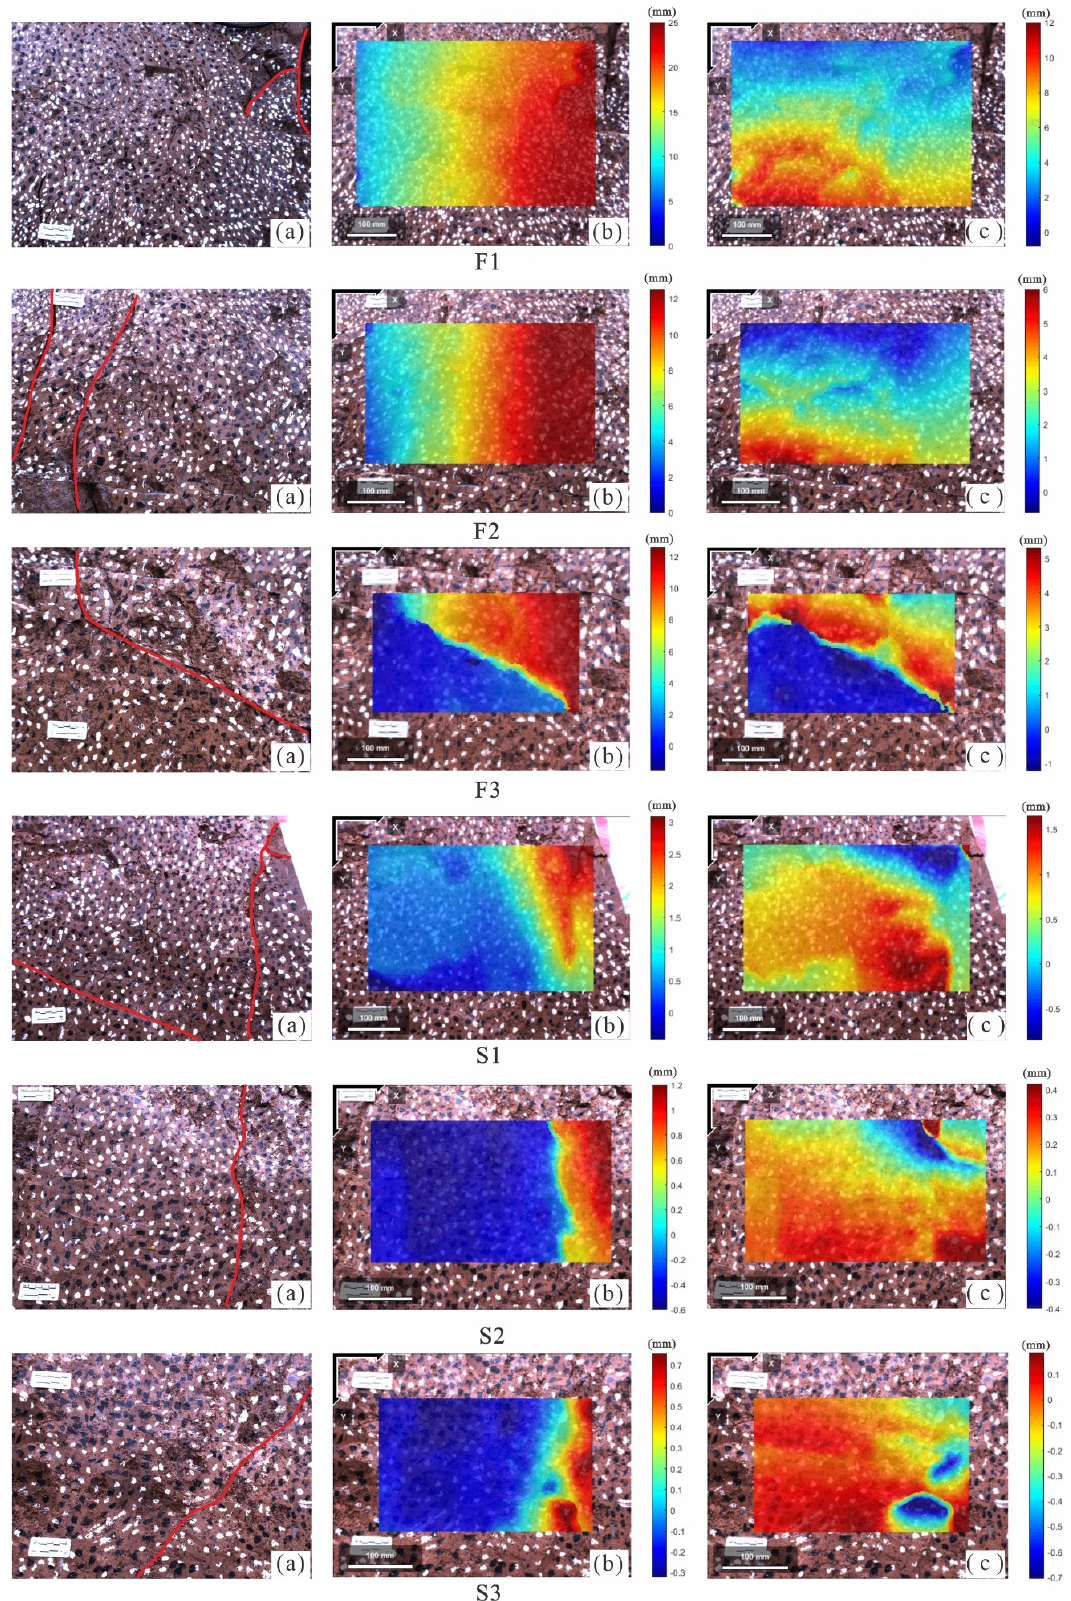
Figure 7. Slope displacement diagram: ( a ) final state of the slope (the red line indicates cracks that can be observed); ( b ) horizontal displacement obtained by the DIC method; and ( c ) vertical displacement obtained by the DIC method.